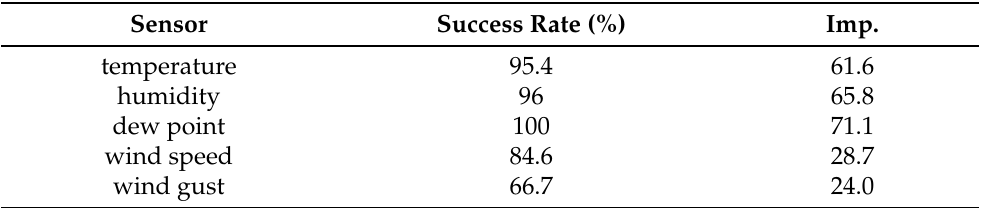
Table 5. Adaptation performance on random tests in the BRASS project evaluation. Imp. shows the average improvement (in %) over the given reference